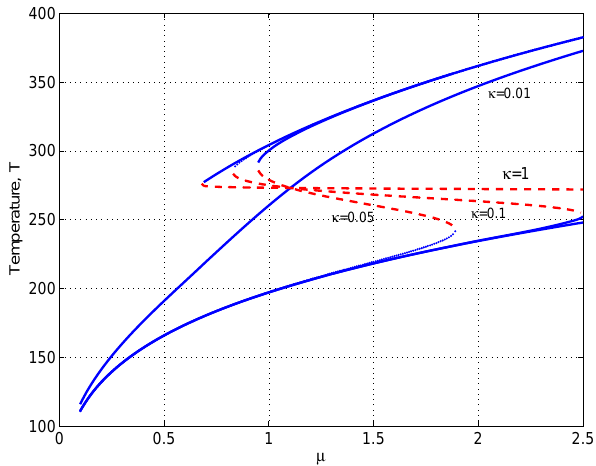
Fig. 6. Equilibrium solutions of the EBM (15) for ice-albedo feed- back functions 𝛼 = 𝛼 ( 𝑇 ; 𝜅 ) given by Eq. (13) and corresponding to the steepness parameter values 𝜅 = 0 . 01 , 0 . 05 , 0 . 1 and 1. Notice the deformation of the stable (blue, solid lines) and unstable (red, dashed lines) solution branches: the “cold” tipping point moves to the left, away from 𝜇 = 1 . 0 , as 𝜅 increases; compare Fig. 3a.